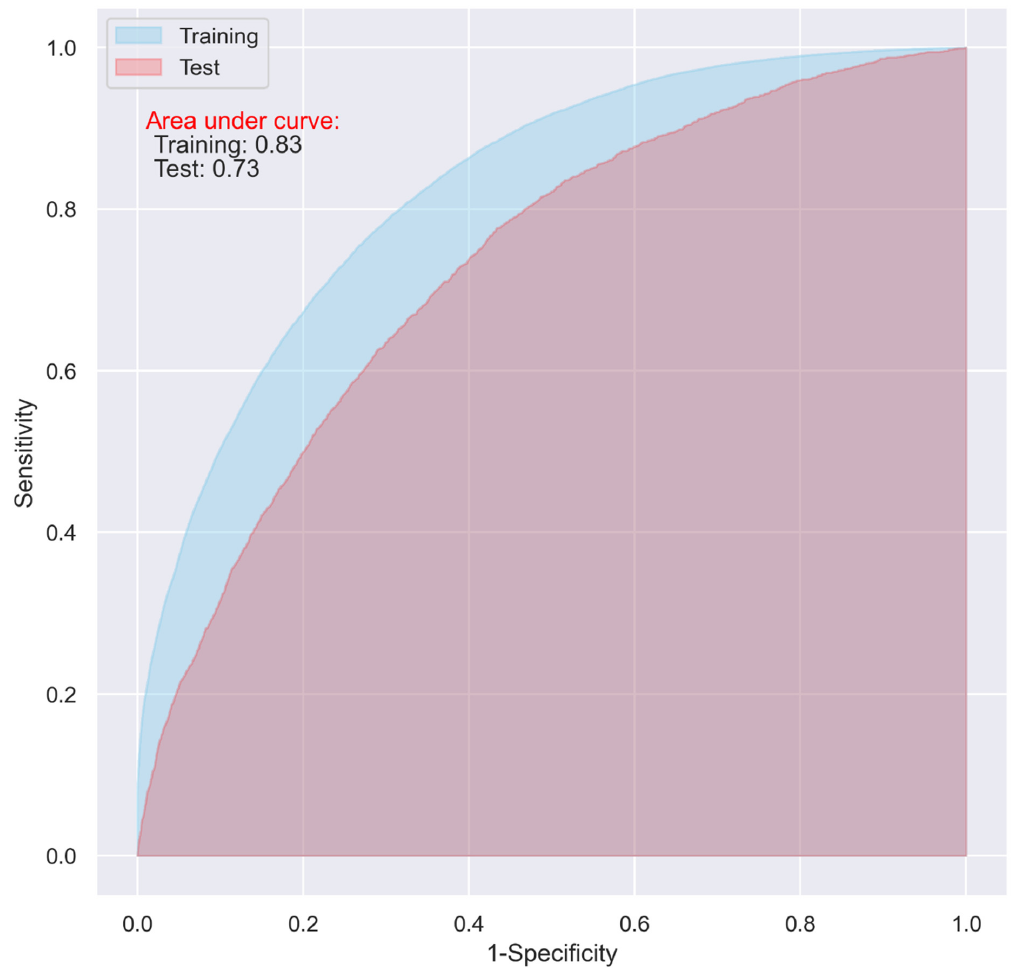
Figure 2. ROC of the LR model including all the variables without penalty. Compared to the CNN model, the LR model exhibited a relatively higher sensitivity (0.57 vs. 0.52), and a comparable specificity (0.75 vs. 0.76) and accuracy (0.73 vs. 0.74) in the test (Table 4). Table 4. Predictive ability of the CNN, LR, and RF